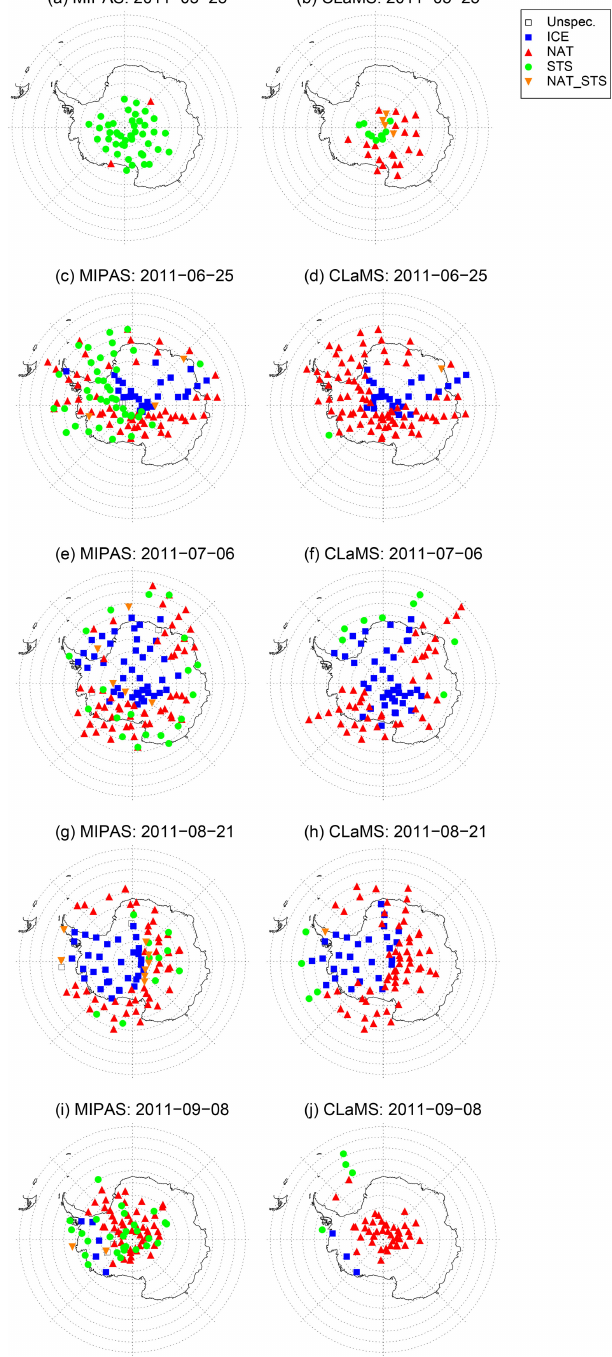
Figure 9. Same as Fig. 4 but for certain days in SH winter 2011: 25 May (a, b) , 25 June (c, d) , 6 July (e, f) , 21 August (g, h) , and 8 September (i, j)